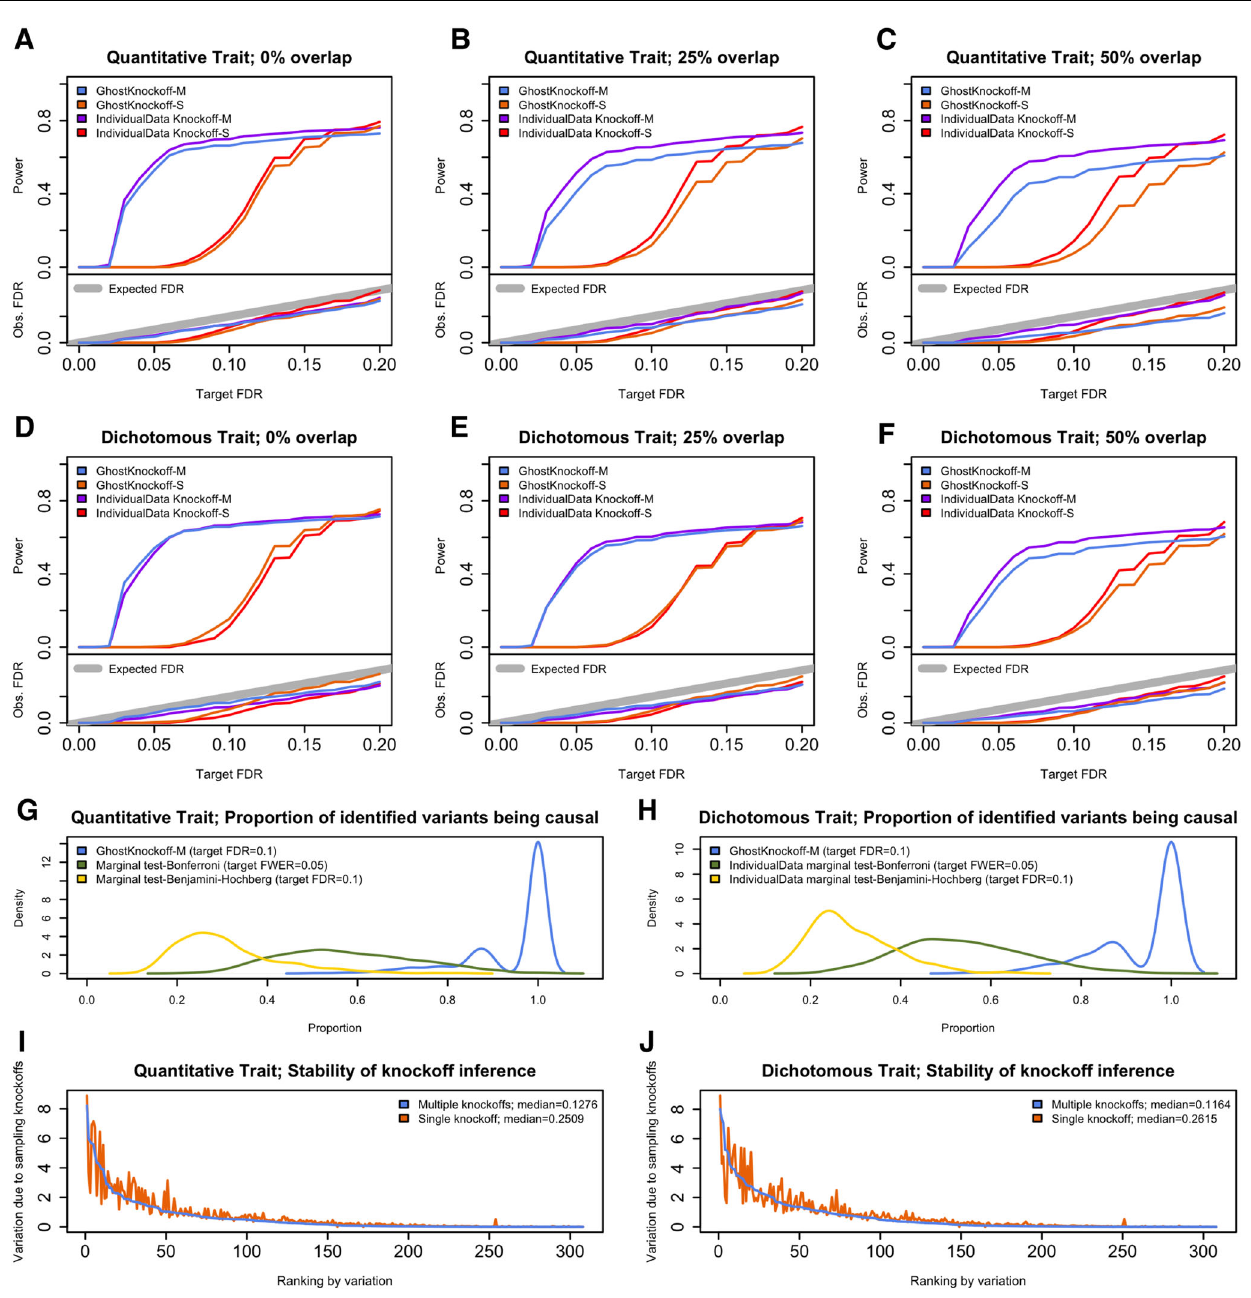
Fig. 2 | Empirical simulation studies for power, FDR and stability. Two cohorts are randomly sampled from the same population. A – F . Power and FDR based on 1000 replicates for different types of traits (quantitative and dichotomous) and different levels of sample overlap (0%/25%/50%), with different target FDR varying from 0 to 0.2. GhostKnockoff-M/S: theproposedmultiple/singleknockoffmethod based on the meta-analysis of Z-scores calculated separately from each individual